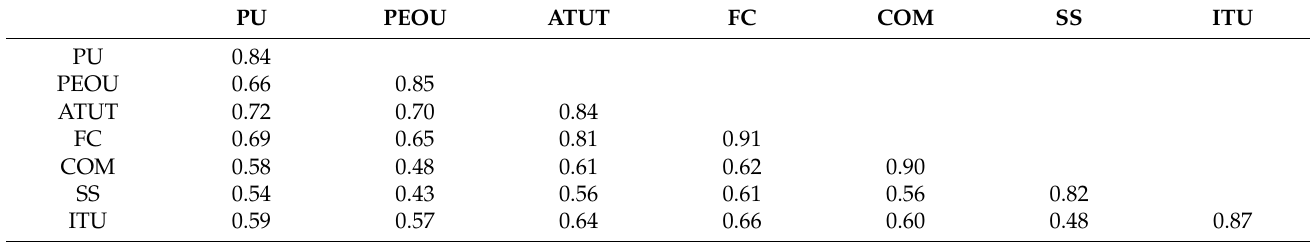
Table 5. Results for the discriminant validity